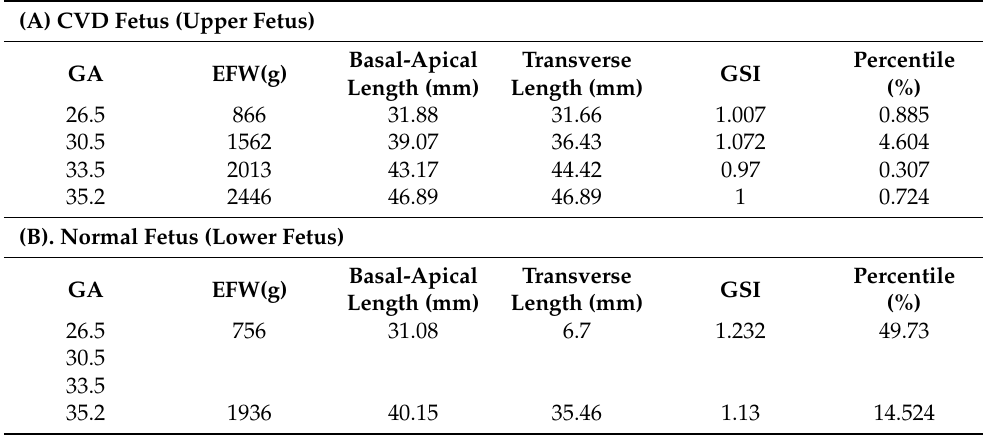
Table 1. (A). CVD fetus (upper fetus). (B). Normal fetus (lower fetus).